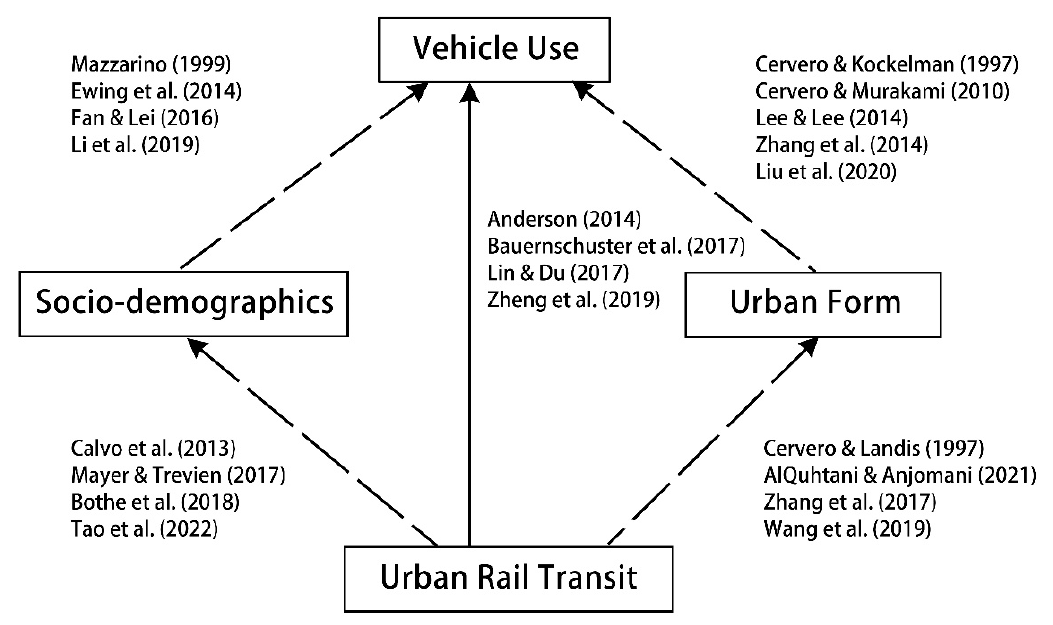
Figure 1. Literature on direct and indirect effects of urban rail transit on vehicle use. Source: Created by the authors [5–8,13–29].